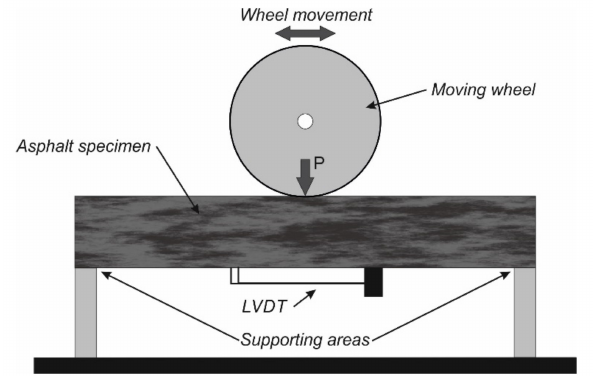
Figure 6. Scheme of the LWT fatigue test setup according to